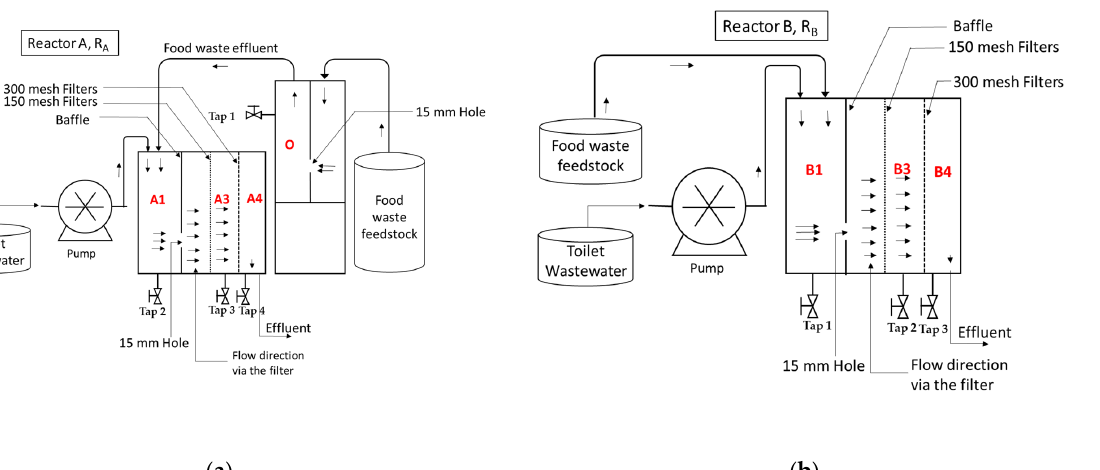
Figure 1. Scheme of experimental set ‐ up for ( a ) two ‐ stage digestion FW and TW (Reactor A, R A ) and ( b ) one ‐ stage digestion FW and TW (Reactor B, R B ) reactors. A1, A3, A4: the first, third, and fourth compartment of reactor A, respectively; likewise, for B1, B3, and B4 for reactor B; O: the compartment of single digestion FW unit for reactor A.